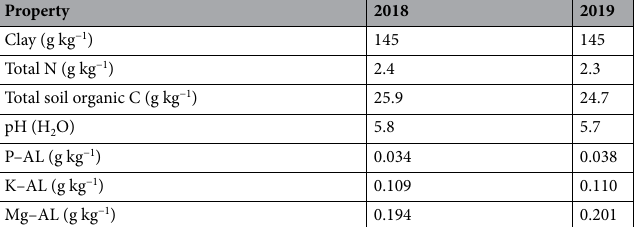
Early‑season Mg:N and P:N ratios were linked to root traits and early vigor.